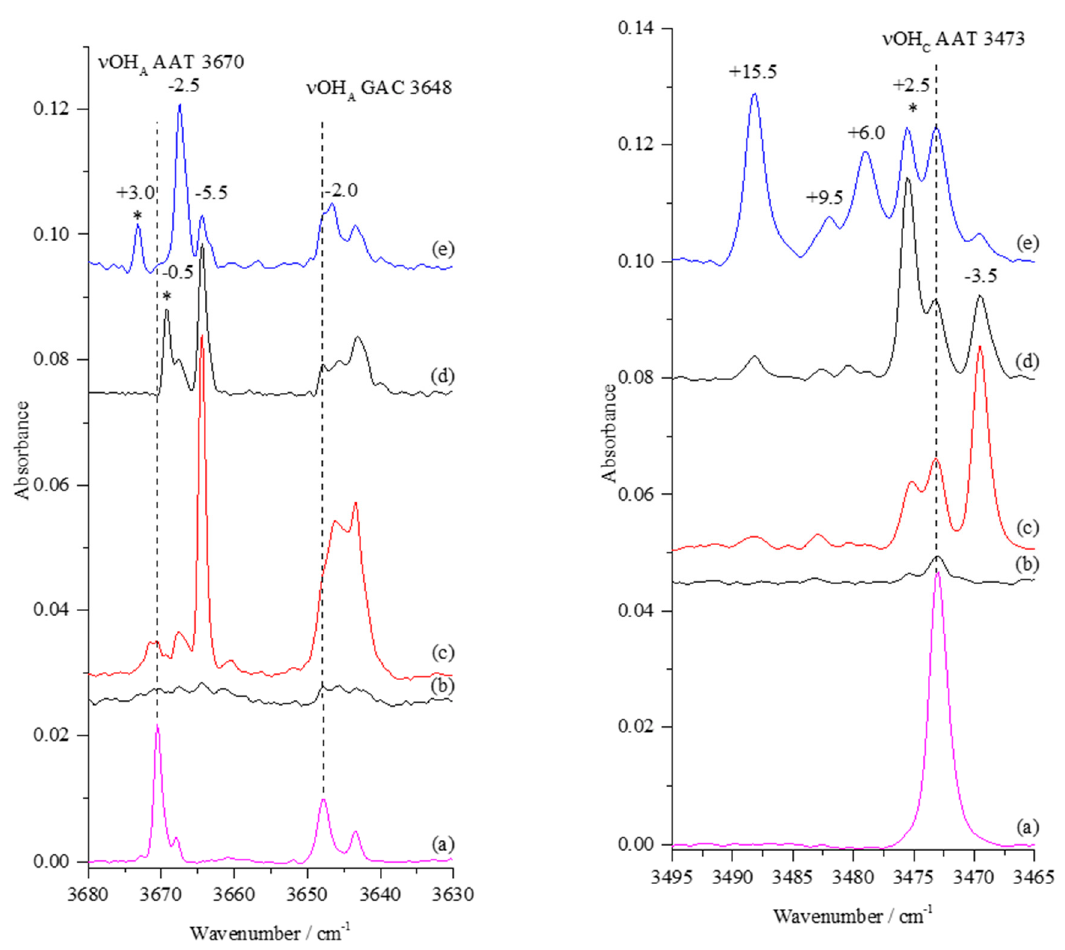
Figure 3. The ν OH regions of the infrared spectra of GAC and AAT monomers and their complexes with nitrogen: ( a ) GA / Ar after deposition at 18 K and two subsequent irradiations at 1438 and 1400 nm; ( b ) after co-deposition, GA with N 2 / Ar = 1 / 4000 at 18 K (10 K for measurement); ( c – e ) upon 360 min irradiation at 1438, 1440, or 1442 nm, respectively. The perpendicular broken lines show position of the GA monomer bands. Stars (*) denote bands disappearing upon annealing.